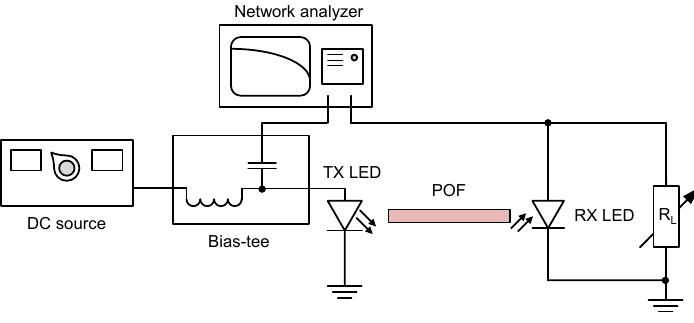
Figure 13. Measurement setup for measuring the bandwidth of the LEDs as a receiver.